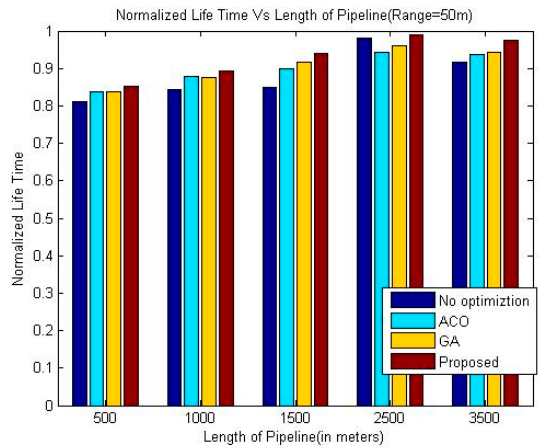
Figure 10. Comparison of Normalized Lifetime (Range 50 m).